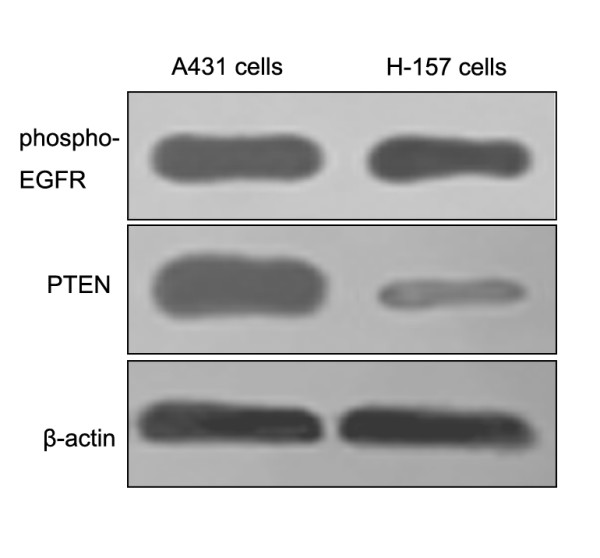
Expressions of EGFR and PTEN in H-157 cells. Western blots of EGFR (upper panel) and PTEN (lower panel) in H-157 cells. Both the EGFR and PTEN highly expressed cells, A431 cells, were taken as positive control.